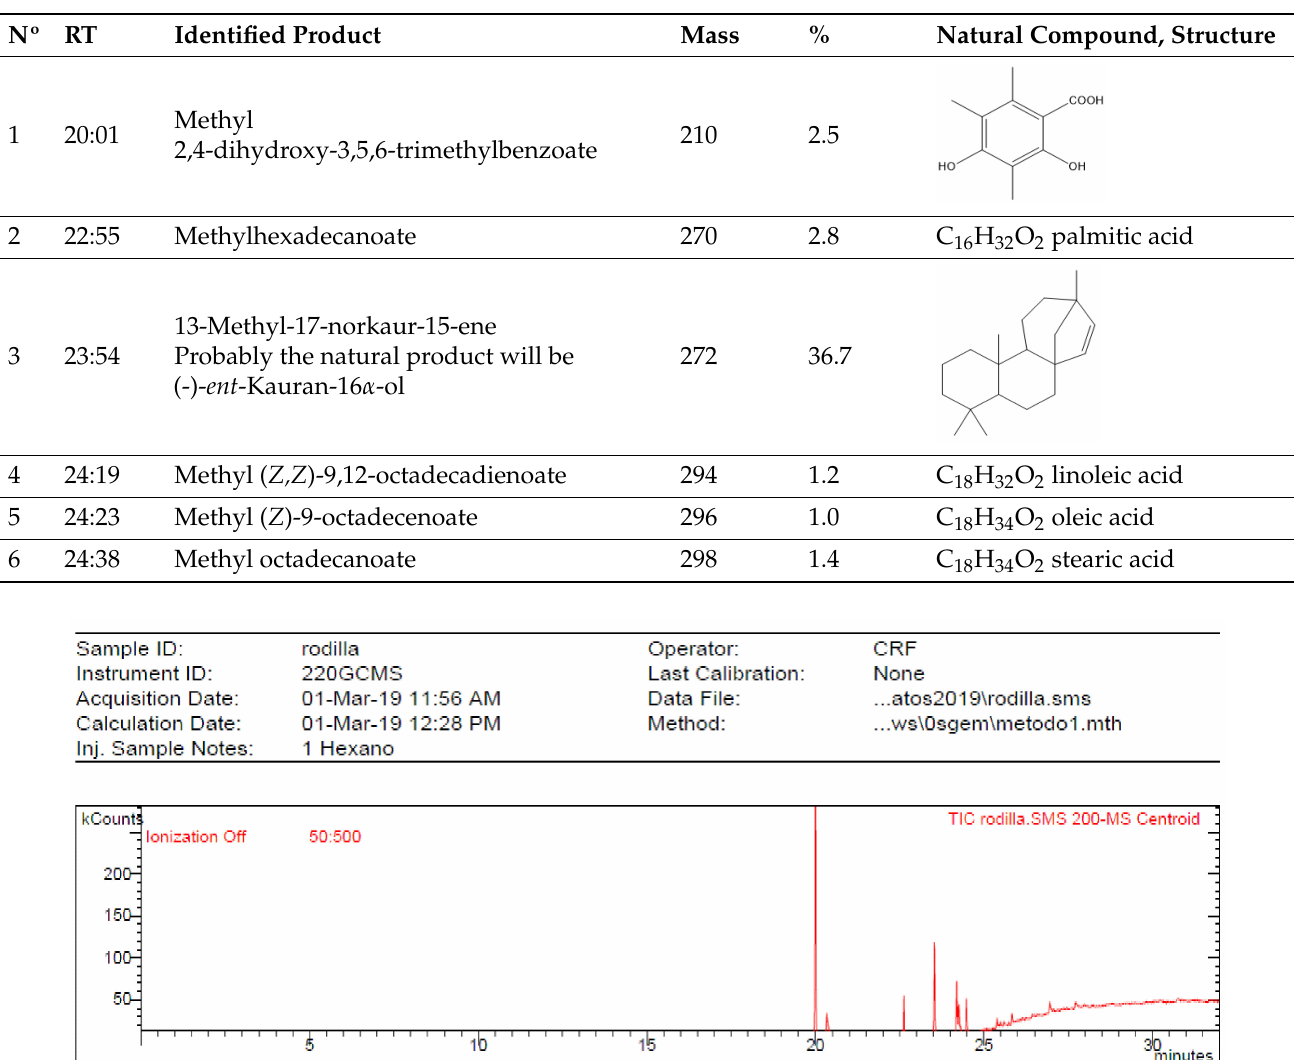
Table 2. Sample Parmotrema hypoleucinum (in Quercus coccifera ), Hexane extract part soluble in MeOH esterified whit diazometane, 2-Hexane .